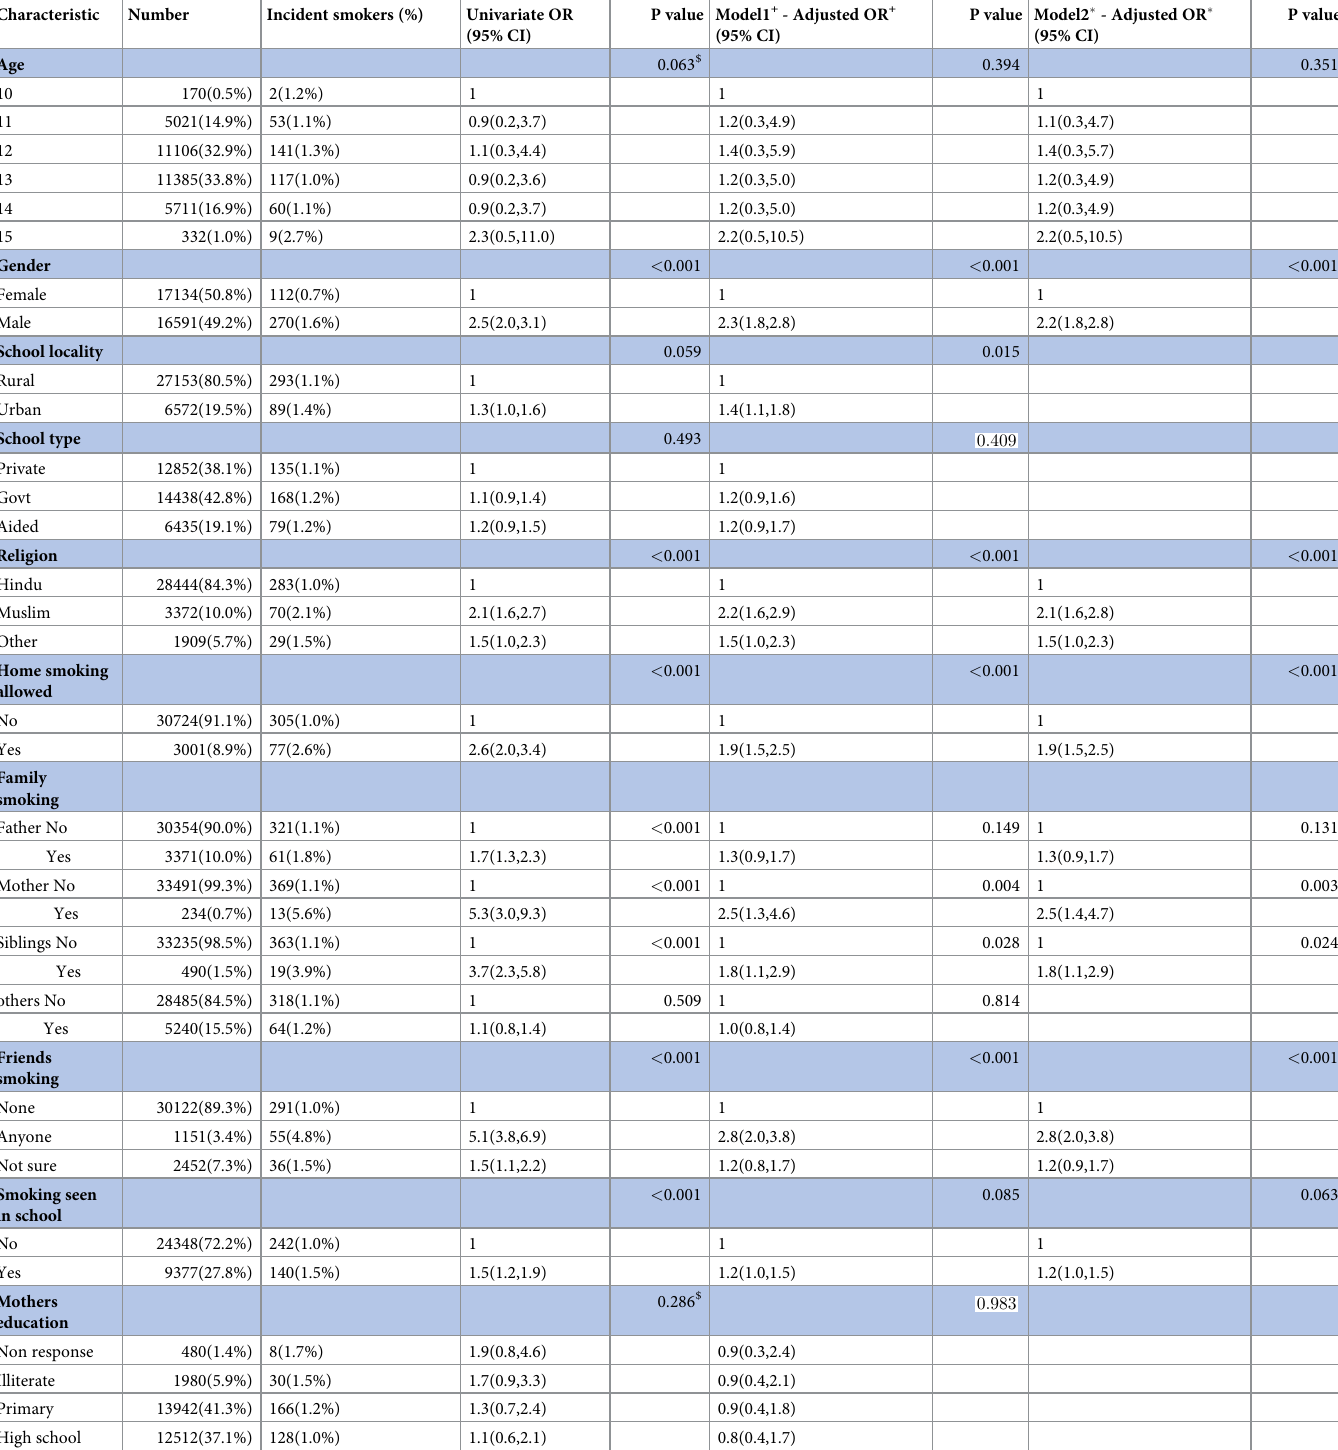
Table 1. Demographic and environmental associations with incident smoking in the study population, including age and sex, showing univariate (Column 4) and statistically significant mutually adjusted odds ratios model before addition of effects of film tobacco exposure as either a binary or graded variable (Column 5 and Column